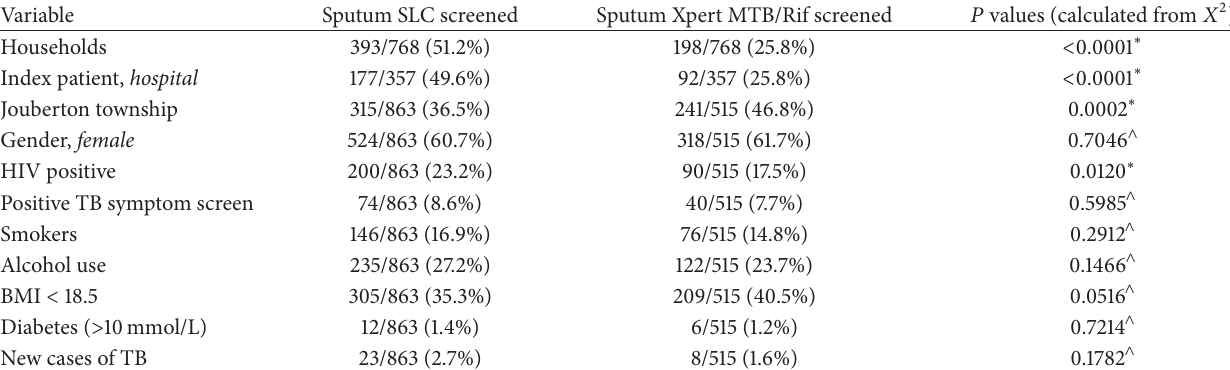
Table 1: Comparison of household contacts characteristics and results following randomization to SLC or Xpert MTB/Rif test.